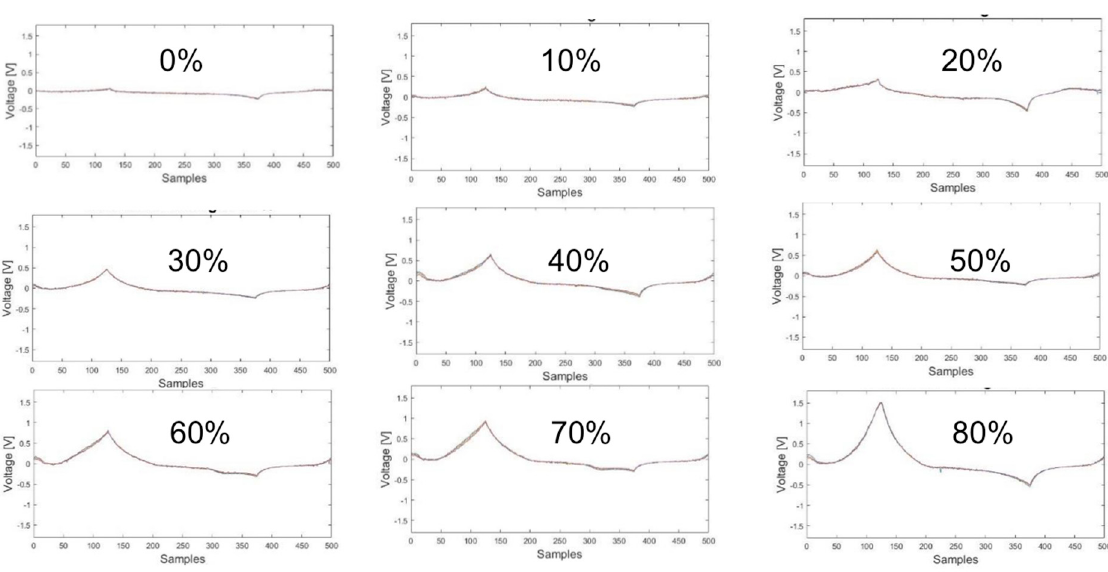
Figure 2. Output voltage signals registered by the system for increasing concentrations of O 2 , from 0% to 80%. The range of interest for real application in the environment is round 20%. The system is able to follow variation round 0.5% around this